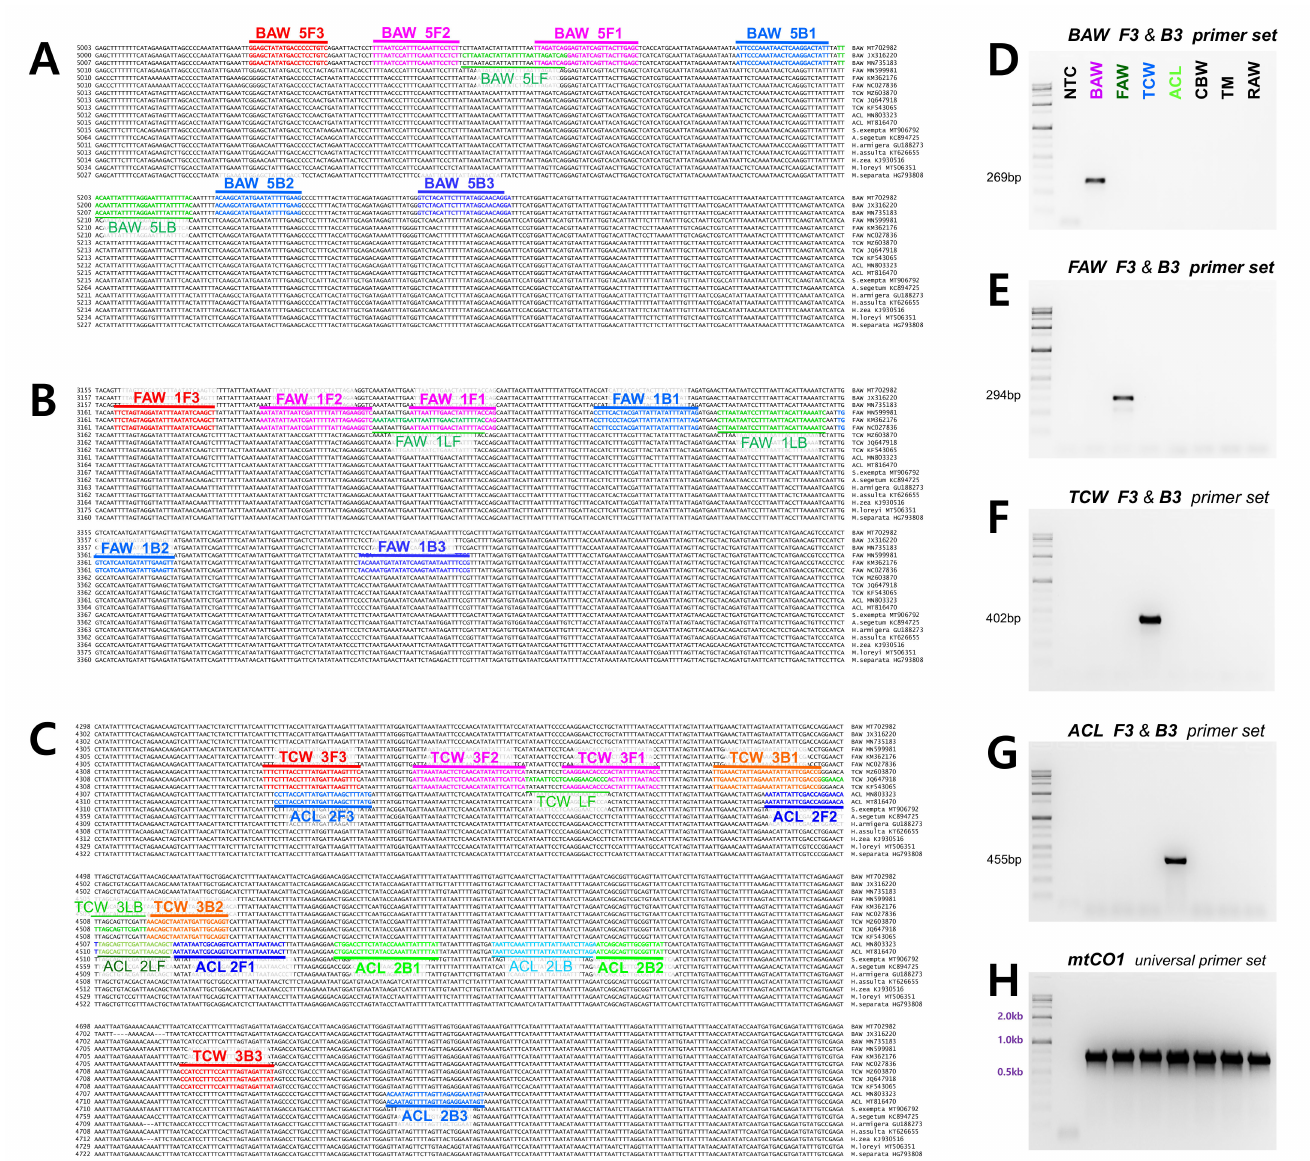
Figure 1. Location of primers and primer binding regions of ( A ) BAW, ( B ) FAW, and ( C ) TCW, ACL on the partial sequences of mitochondrial genomes from five Spodoptera species and additional six Noctuidae species. In total, 18 sequence were aligned to pick species-specific regions for primer design. F3 and B3 are the main diagnostic primers. The inner primer, FIP, consists of F1c (complementary sequences of F1) and F2. The other inner primer, BIP is also composed of B1 and B2c (complementary sequences of B2). The four essential LAMP primers (F3, FIP, BIP, and B3) generate the dumbbell structure, and the two loop primers, LF and LB, accelerate the LAMP reaction. Diagnostic external LAMP primers, F3 and B3 were confirmed via PCR ( D ) BAW, ( E ) FAW, ( F ) TCW, ( G ) ACL, and ( H ) PCR with universal primer set (mtCO1) within seven species (BAW, FAW, TCW, ACL, CBW, TM, RAW). NTC: no template control, BAW: Beet armyworm, S. exigua ,